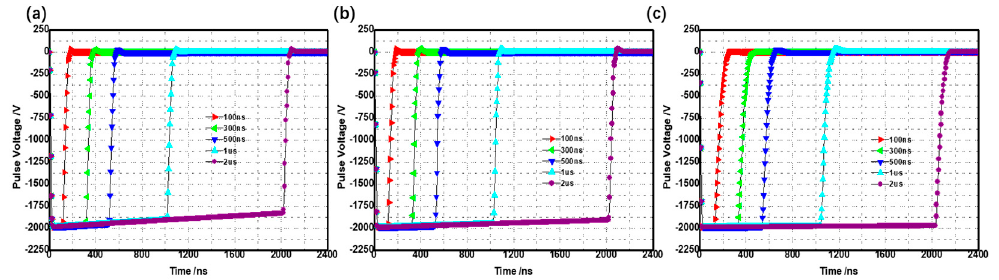
Figure 6. The voltages on the different loads with various resistances under the 24 pF capacitance. ( a ) The load resistance is 50 Ω ; ( b ) the load resistance is 100 Ω ; and ( c ) the load resistance is 1000 Ω